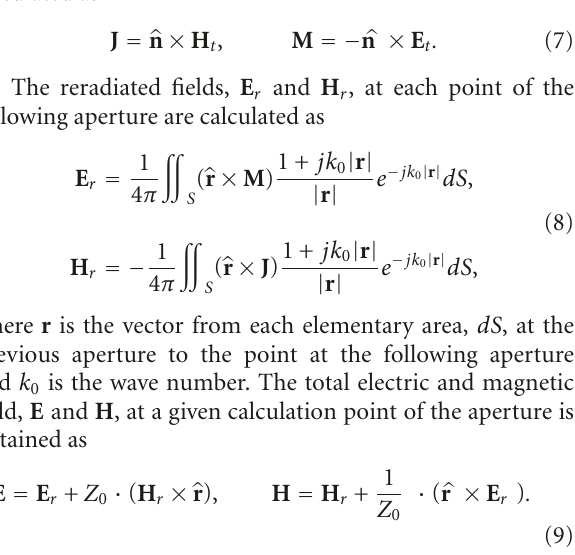
Figure 12: Example of PO results (path loss in dB) for row 5. Table 4: Measured attenuation introduced by the haul of the